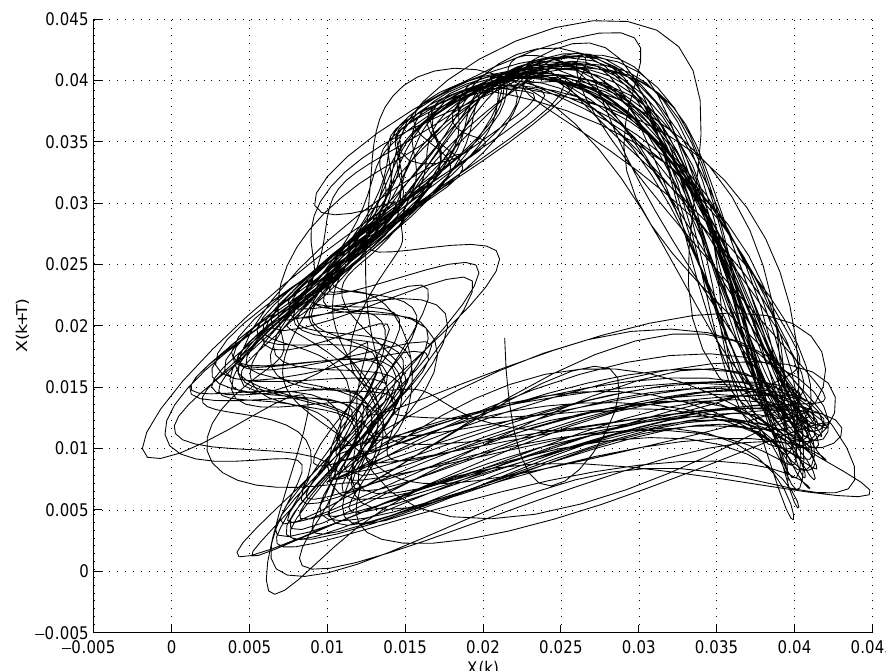
Fig. 11. Reconstructed space state for case 5 with low pass